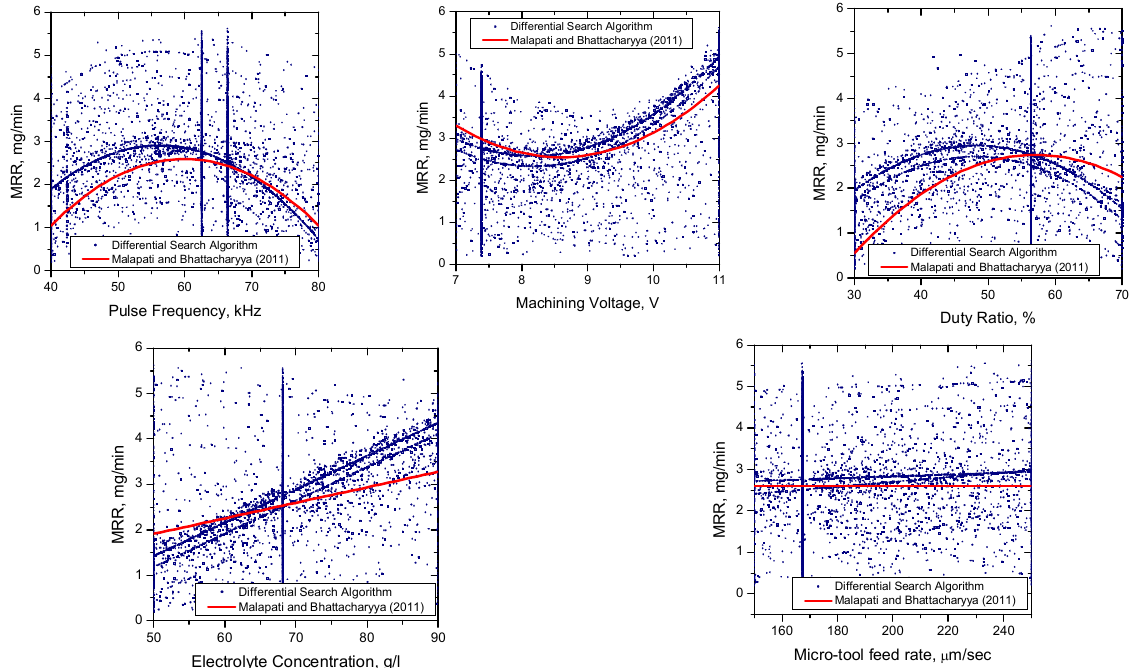
Fig. 2. Change of MRR with respect to various EMM process